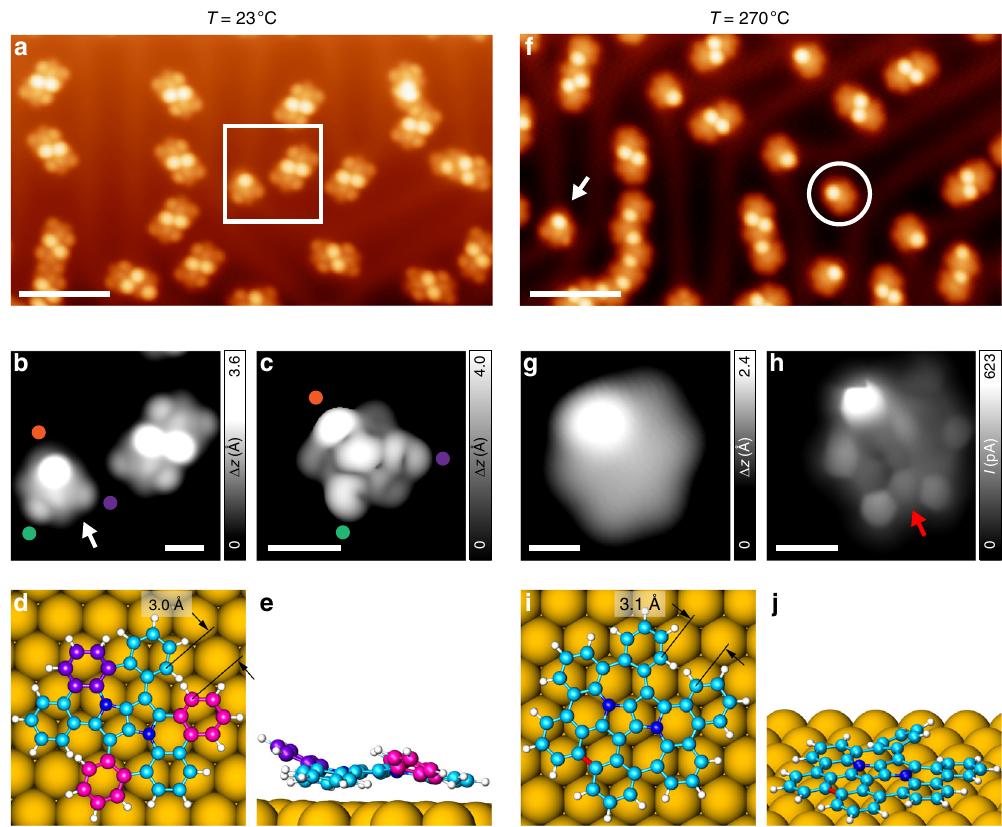
Fig. 3 On-surface reaction of 6b on Au(111). a Overview STM topography image of the surface after room temperature deposition of 6b , showing the predominant presence of self-assembled dimers ( V = − 1 V, I = 50 pA, scale bar: 5 nm). b High-resolution STM image of the highlighted area in a , consisting of a dimer, and an isolated molecule indicated with the white arrow ( V = − 1 V, I = 70 pA, scale bar: 1 nm). c DFT-simulated STM image of 6b corroborating the experimentally observed features ( V = − 1 V, scale bar: 1 nm). The colored dots serve as a guide to the eye for comparing the intramolecular features in experimental and simulated STM images. d , e Top and side views of the DFT equilibrium geometry of 6b . Rings highlighted in violet and magenta colors show an out-of-plane bending contributing to the distinguishing features in the STM images. f Overview STM topography image of the surface after annealing to 270 °C ( V = − 1 V, I = 40 pA, scale bar: 5 nm). The white circle highlights the half-closed species 7b . The white arrow indicates a still-present 6b on the surface. g High-resolution STM image of 7b ( V = 10 mV, I = 50 pA, scale bar: 0.5 nm). h Corresponding UHR-STM image of 7b (open feedback parameters: V = − 5 mV, I = 50 pA; Δ z = − 40 pm; scale bar: 0.5 nm). The red arrow indicates the hexagonal ring formed after